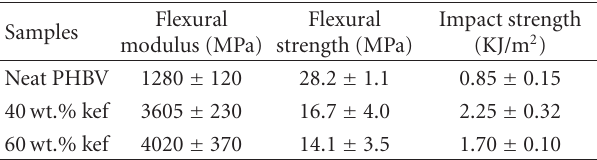
Table 3: Flexural and impact properties of PHBV